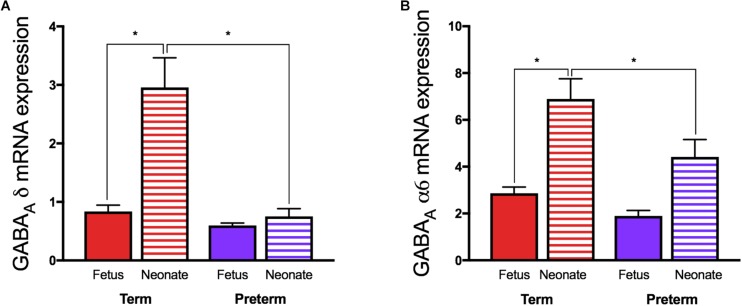
Relative mRNA expression of the GABAA receptor (A) δ and (B) α6 subunits in guinea pig cerebellum. Fetal tissue was obtained at GA69 (term) and GA62 (preterm) ages, and neonatal tissue from 24 h after term or preterm birth. (*p < 0.05, n = 11–16). Adapted and reprinted with permission from Shaw et al. (2015).